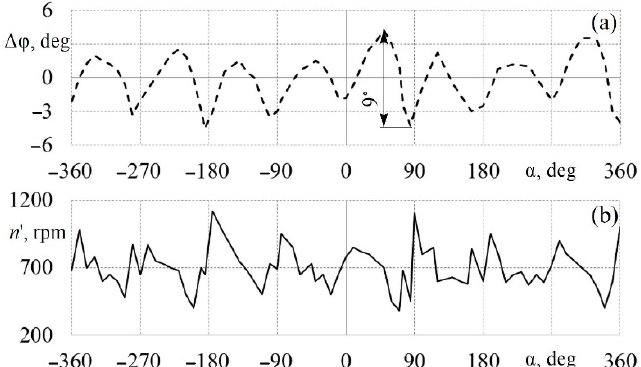
Figure 9. Dependence of the instantaneous values of the rotational speed n ’( a ) and the deflection angle of the pump shaft cam Δφ ( b ) on the rotation angle of the pump camshaft α in the nominal operating mode of a diesel engine (21/21).